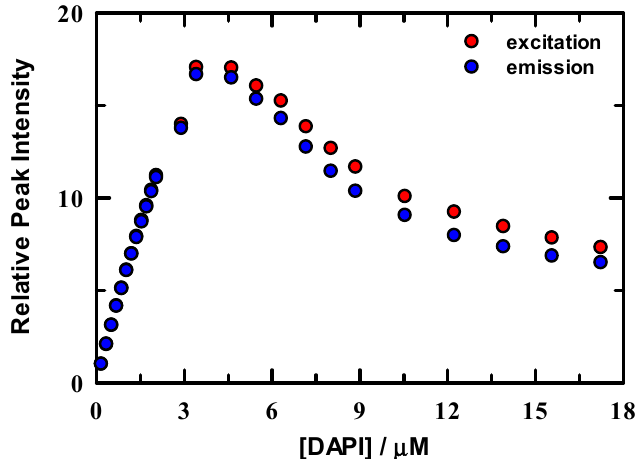
Figure 2. Normalized fluorescence intensities of DAPI in solution with 2.5 μ M DNA/10 mM tris buffer at pH = 7.0. Data were normalized to the peak intensity for excitation (red) and emission (blue).